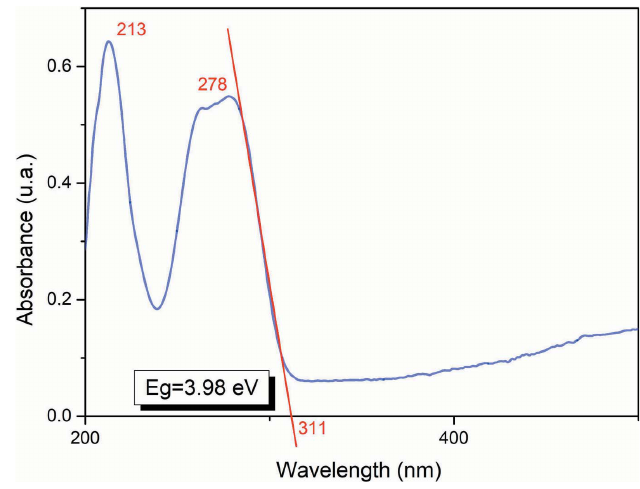
Figure 8 UV–vis spectrum of (I). The inset shows the experimental energy band gap obtained from the absorption edge wavelength.